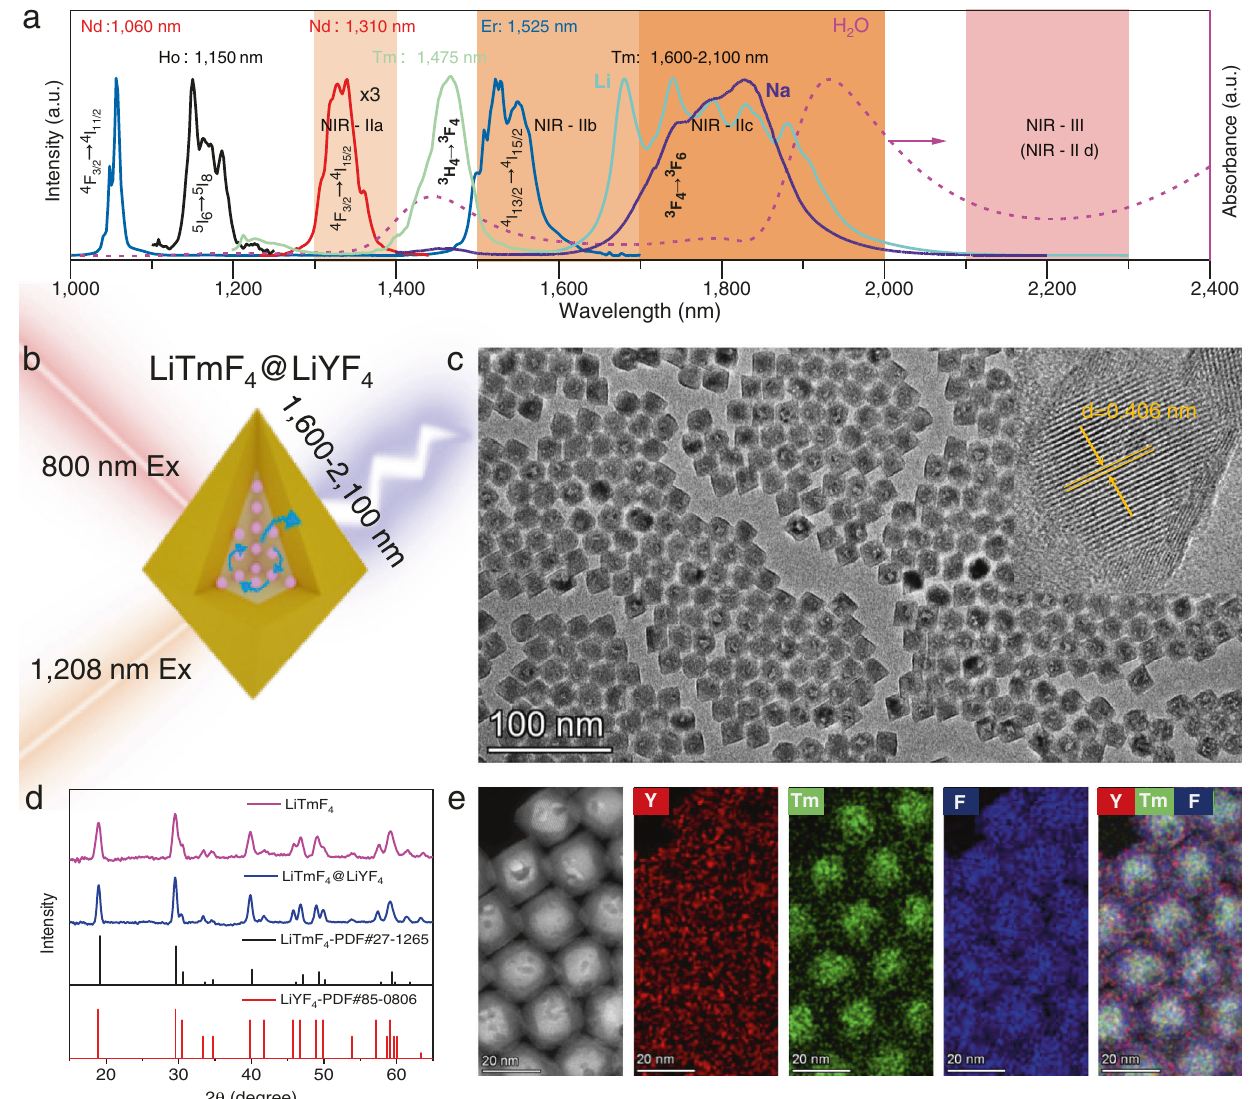
Fig. 1 | Characterization of Tm-NPs and typical NIR emission of RE 3+ . a Typical DSL spectra of rare-earth ions (Nd: NaGdF 4 :30%Nd; Ho: NaYF 4 :10%Yb:1%Ho; Er: